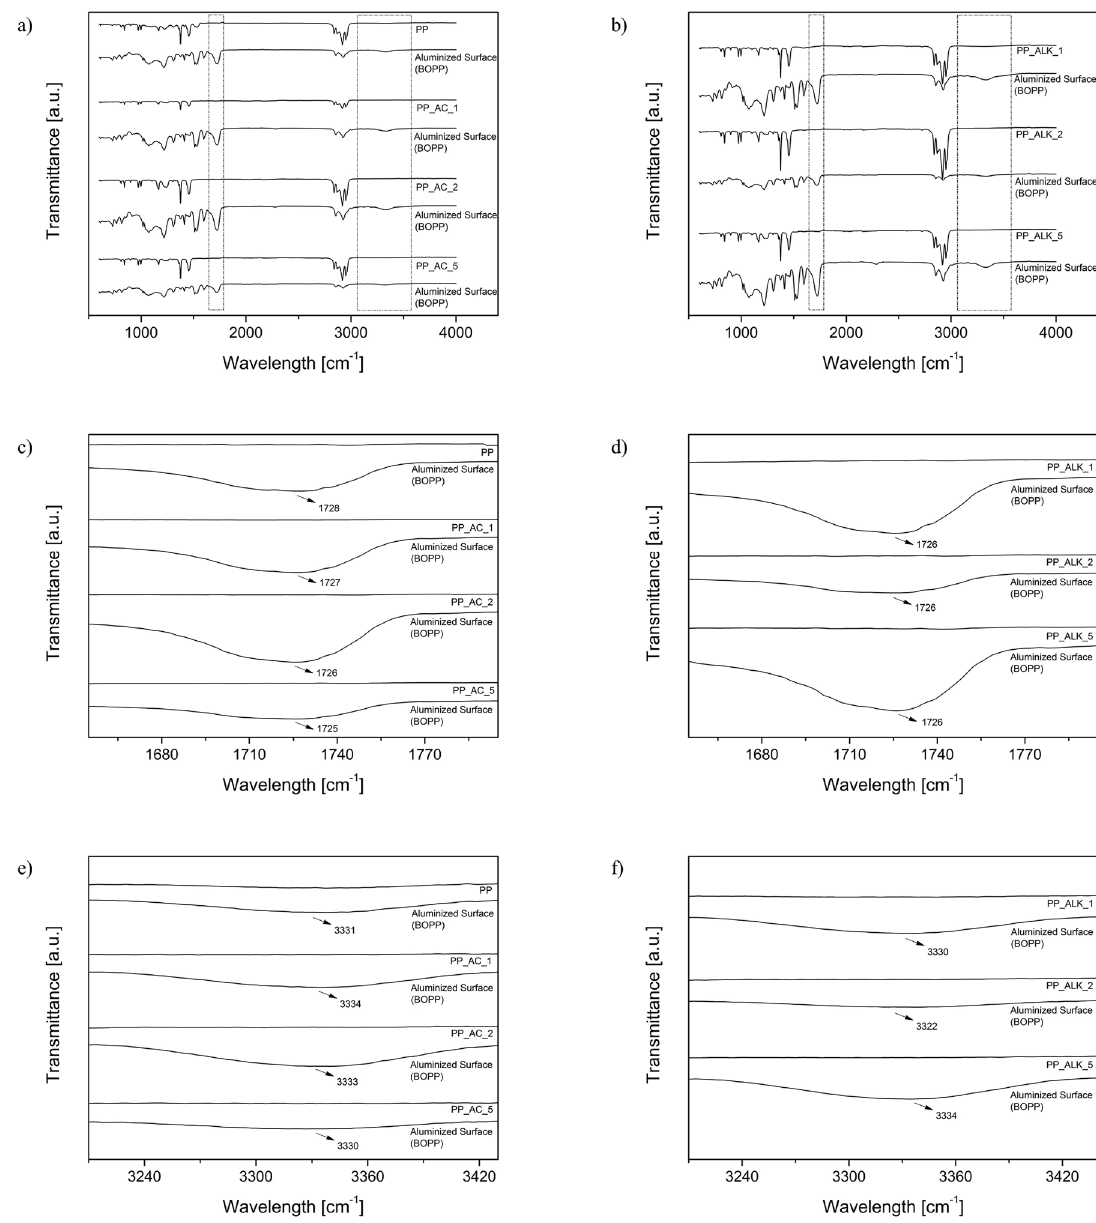
Figure 2. FTIR spectra for PP films with (a) AC and (b) ALK (without CDT) compared to BOPP after peel strength. Amplifications of the bands of 1725 cm -1 (c and d) and 3330 cm -1 (e and f) for AC and ALK, respectively